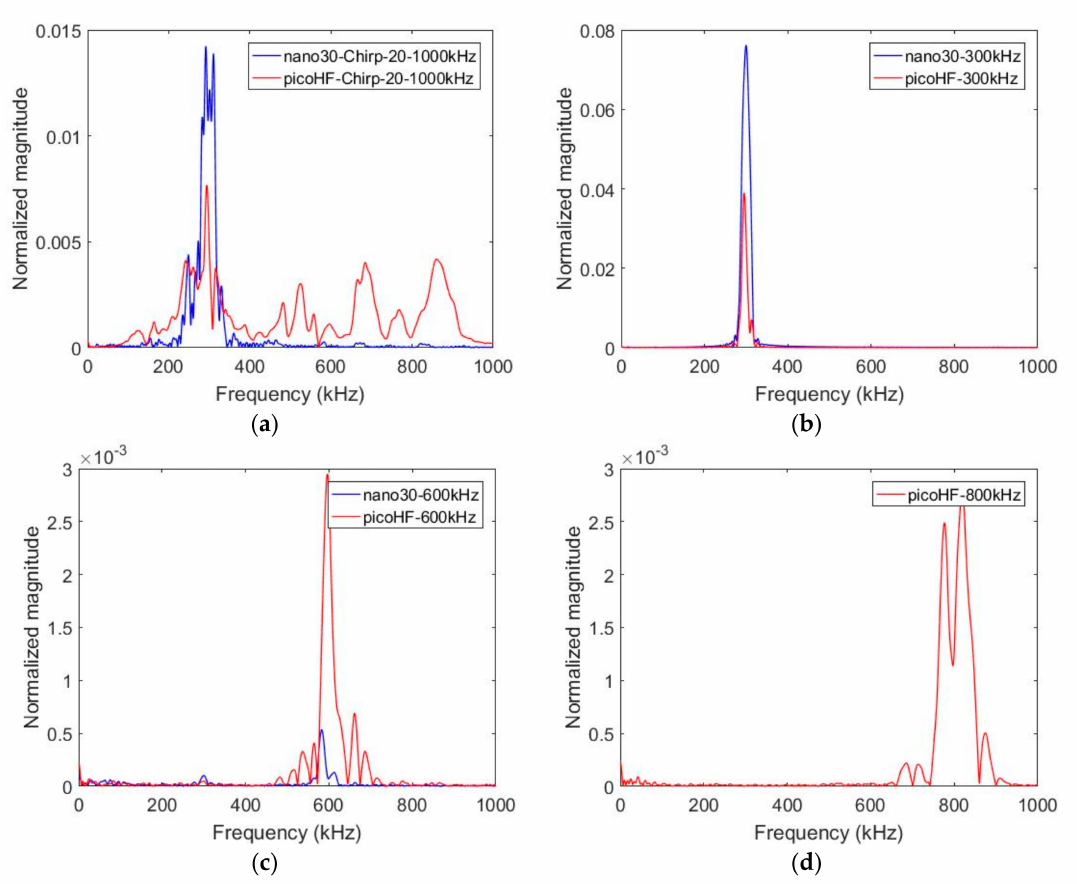
Figure 5. Fast Fourier Transform (FFT) of the recorded signals with Nano30 sensor and PicoHF sensor for emitted signals at di ff erent frequencies ( a ) chirp, ( b ) 300 kHz, ( c ) 600 kHz, ( d ) 800 kHz generated by an acousto-ultrasonic card. The input signal is generated with a specific frequency, amplitude of 5 volts and a rise time of 20 µ s. (Propagation distance of 20 mm, epoxy material propagation, actuator Micro80 sensor). ( a ) Chirp, ( b ) 300 kHz, ( c ) 600 kHz and ( d ) 800